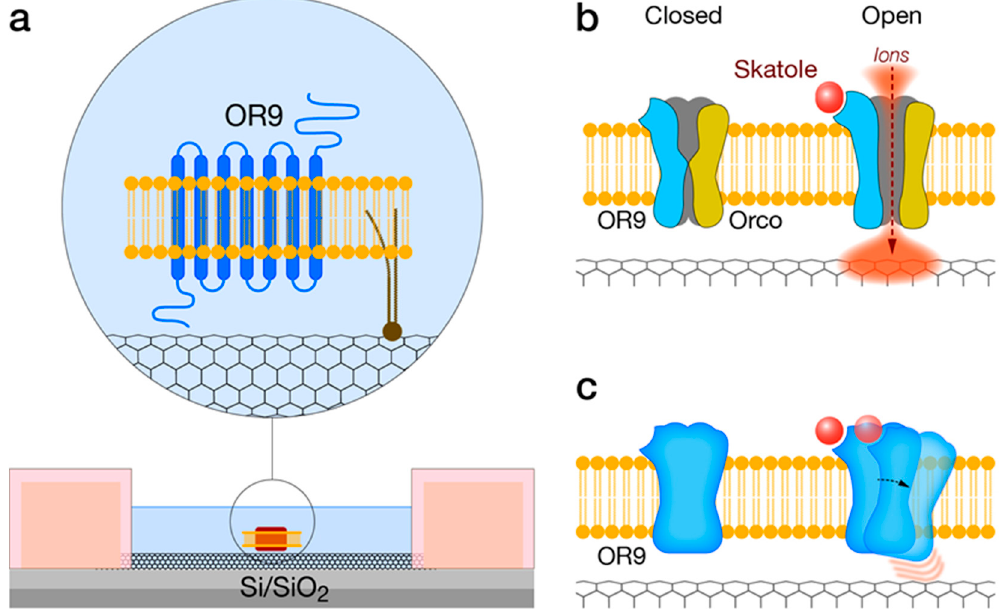
Figure 6. IndolOR-based biosensor. ( a ) Diagram of a bioelectronic sensor showing carbon nanotube field-effect transistor devices. Membrane-enriched OR9 are covalently conjugated to the carbon nanotube sidewall via a phospholipid linker. ( b ) Skatole binding-induced opening of the cation ion channel generates a cation influx transiently locating positive charges near the sidewall, resulting in a significant electric field-effect. ( c ) Conformational changes of OR9 following skatole binding alter charge distribution near the sidewall, which in turn affect the local electric field, resulting in modulated conductance of the CNT.